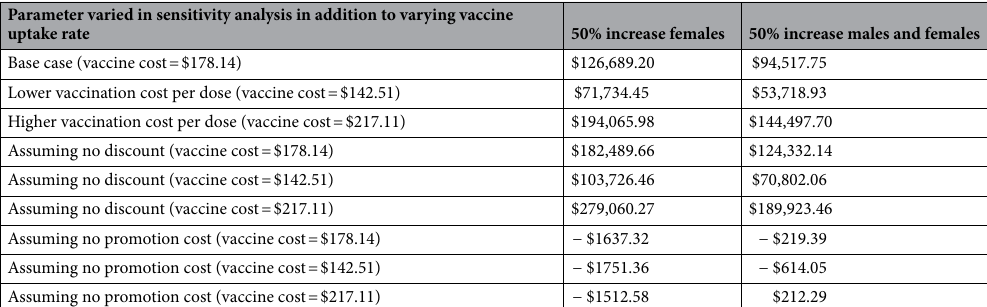
Parameter varied in sensitivity analysis in addition to varying vaccine uptake